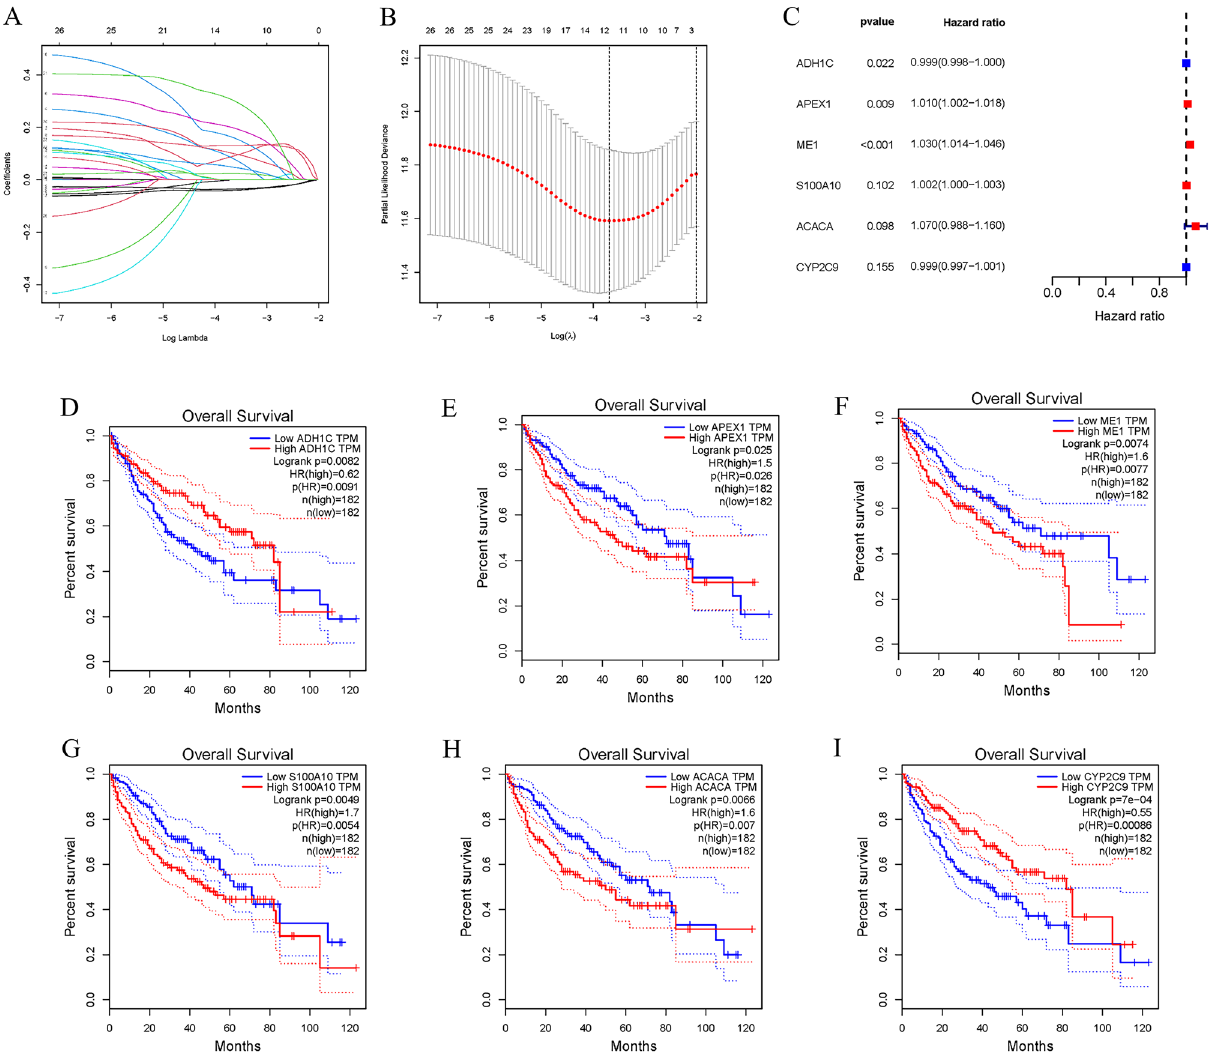
Figure 2. Construction of a prognostic model. ( A ) Plots for LASSO expression coefficients of 27 lipid metabolism related genes. ( B ) Cross-validation plot for the penalty term. ( C ) Relationship between four glycolysis-related lncRNAs and prognosis of HCC patients. ( D – I ) Survival curves of patients with differential expression of six genes in